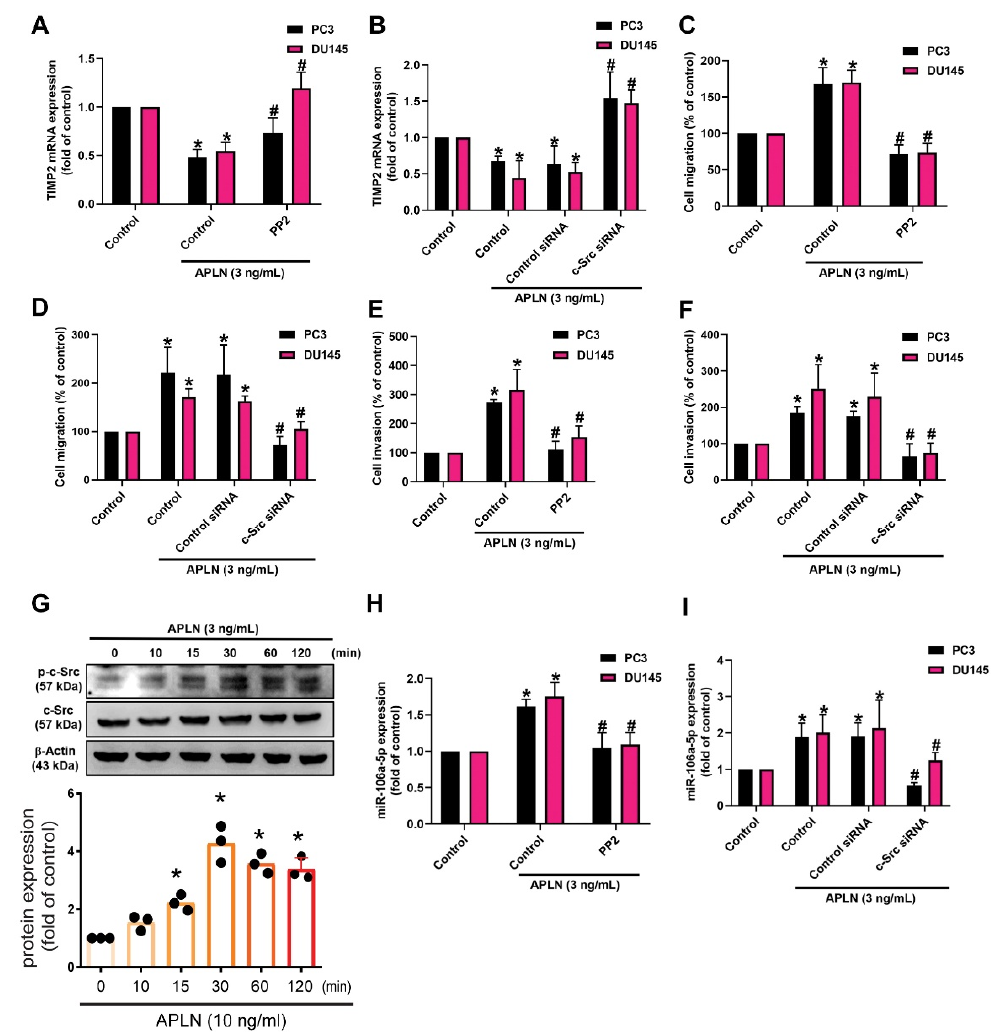
Figure 5. The c-Src pathway is mediated in apelin-induced migration and invasion of prostate cancer cells. ( A – F , H , I ) Cells were applied with the c-Src inhibitor (PP2; 1 µ M) or siRNA, then incubated with apelin, before examining cell migration ( n = 4) and invasion ( n = 4), TIMP-2 and miR-106a-5p expression ( n = 4). ( G ) PC3 cells were treated with apelin, then c-Src phosphorylation was investi- gated by Western blot (up-panel) and the quantify data were provide in low panel ( n = 3). * p < 0.05 compared with the control group; # p < 0.05 compared with the apelin-treated group. Dots of bar graph means the repeat number of Western blot assay.